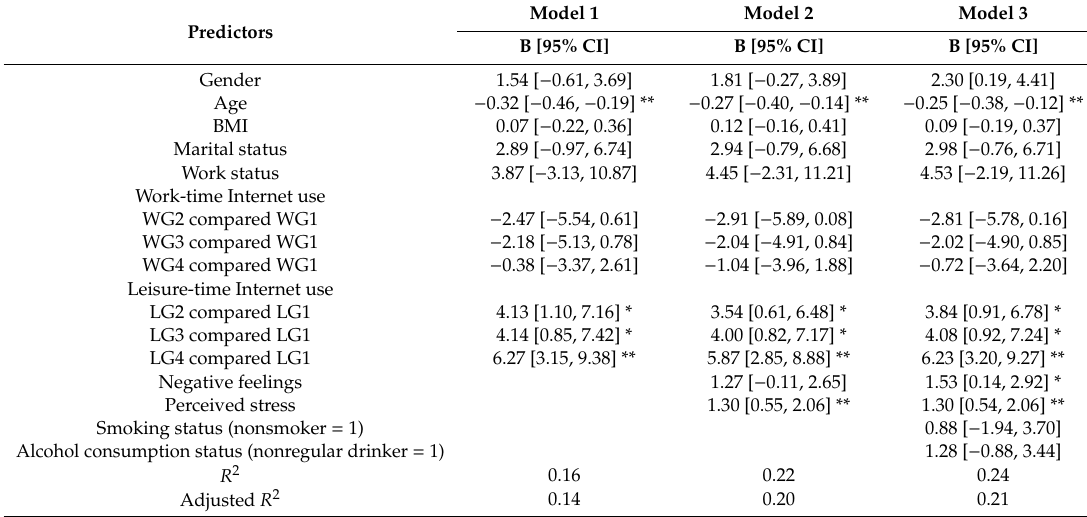
Table 3. Regression models predicting problematic internet